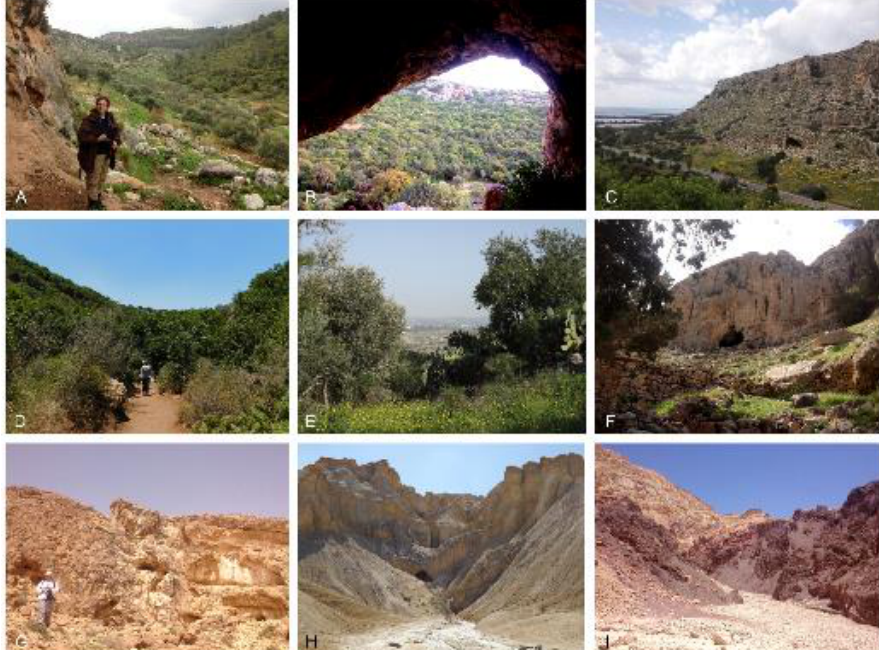
Figure 2. Caves and habitats from the survey (cave numbers in parentheses). ( A – C ): Northern Israel, Mediterranean climate. ( A ): The area near the opening of Yonim cave (upper Galilee, 5). ( B ): The north-facing slope of Oren wadi where Ezba’ cave (12) is located (taken from Oren cave, Karmel). ( C ): The south-facing slope of Oren wadi where Oren cave (Karmel, 10) is located. ( D – F ): Central Israel and Palestine, Mediterranean and semi-arid climates. ( D ): The area near the opening of Teomim cave (Judean Mountains, 24). ( E ): The area near the opening of Haruva cave (HaShfela, 18). ( F ): The north-facing slope of Perat wadi where ‘Perat Inbal cave (cave 1, northern Judean desert, Palestine, 20) is located. ( G – I ): Southern Israel, arid climates. ( G ): The east-facing slope where Zavoa cave is located (southern Judean desert, 25). ( H ): The east-facing slope where Arubotayim cave is located (southern Dead-sea region, 26). ( I ): The area where Ammude Amram caves are located (Arava valley, 34–35). Pictures: ( A – C ), ( F – I ) Shlomi Aharon, ( D , E ) Igor Armiach Stein-